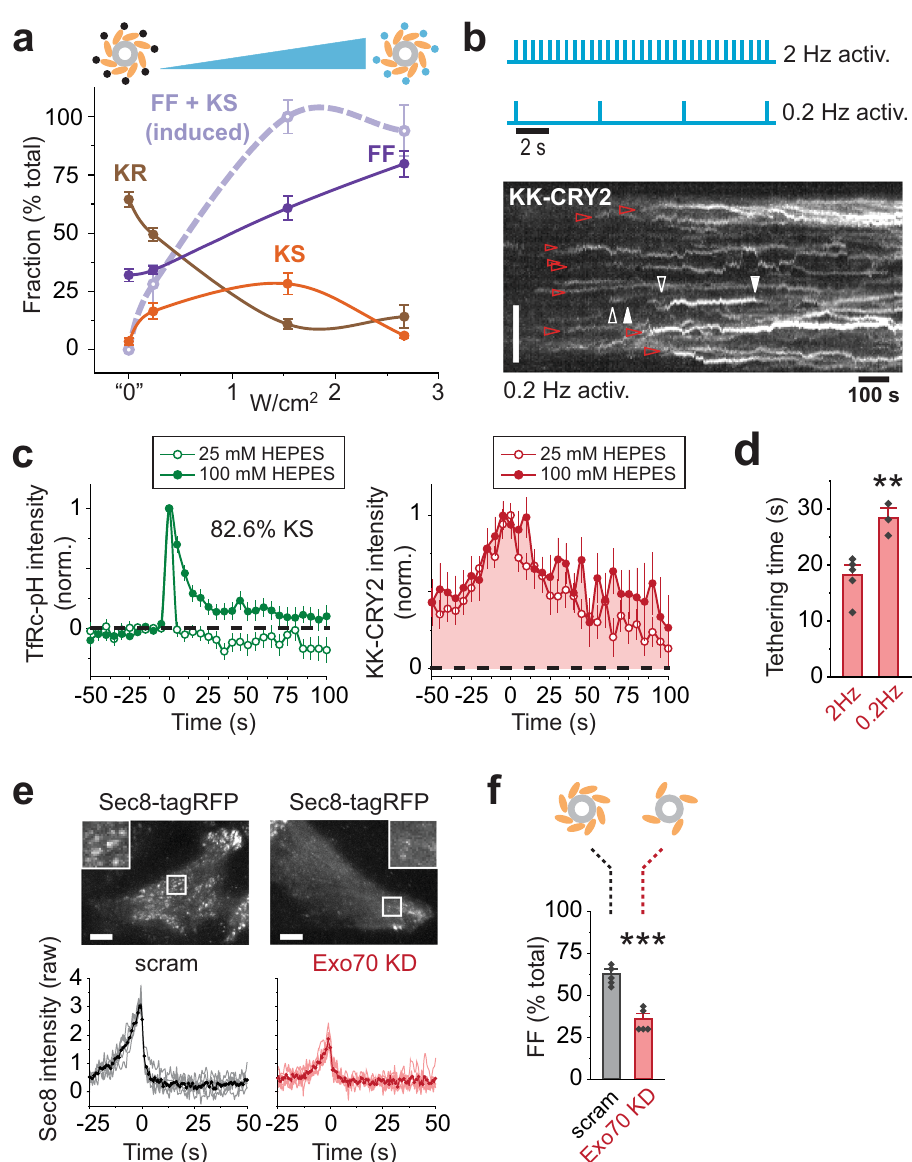
Fig. 4 Mode of vesicle fusion depends on degree of Exo70 membrane engagement. a Dose – response relationship between light intensity and fusion mode with Exo70-KK – CRY2. Laser power densities used were 0.23, 1.5 and 2.6 W/cm 2 . “ 0 ” intensity activation re fl ects the – CIB condition. n = 4 cells for 0 intensity and n = 5 cells for all other intensities. Cartoon depicting activation of CRY2 (black/cyan circles) attached to exocyst complexes (orange ovals) serves as a simpli fi ed interpretation. b Schematic of high (2 Hz) and low (0.2 Hz) activation frequencies (top). Kymograph of Exo70-KK – CRY2 during low frequency activation (bottom). Red arrowheads mark stuck vesicles. Vertical scale bar, 6 μ m. c TfRc-pH (green) and Exo70-KK – CRY2 (red) traces produced with low frequency activation, time aligned to fusion. Averages of pooled events are shown ( n = 52 and 36 events for 25 and 100 mM HEPES, respectively). Mean ± SEM. d Comparison of tethering half-times produced with high (2 Hz) and low (0.2 Hz) frequency activation of Exo70-KK – CRY2. n = 5 and 3 cells for 2 and 0.2 Hz activation, respectively. Mean ± SEM (*** P = 0.0010, two-tailed Student ’ s t -test). e Effect of Exo70 knockdown (KD) on exocyst stability. Visualization of exocyst complexes with Sec8-tagRFP (top). Scale bars, 6 μ m. Sec8 traces (averages of cell averages) time-aligned to fusion with (red) or without (black) Exo70 KD (bottom). n = 5 cells for both scram and Exo70 KD. f Effect of Exo70 KD on FF frequency. Mean± SEM (*** P = 1.9 × 10 − 4 , two-tailed Student ’ s t -test). Cartoon depicting number of exocyst complexes serves as a simpli fi ed